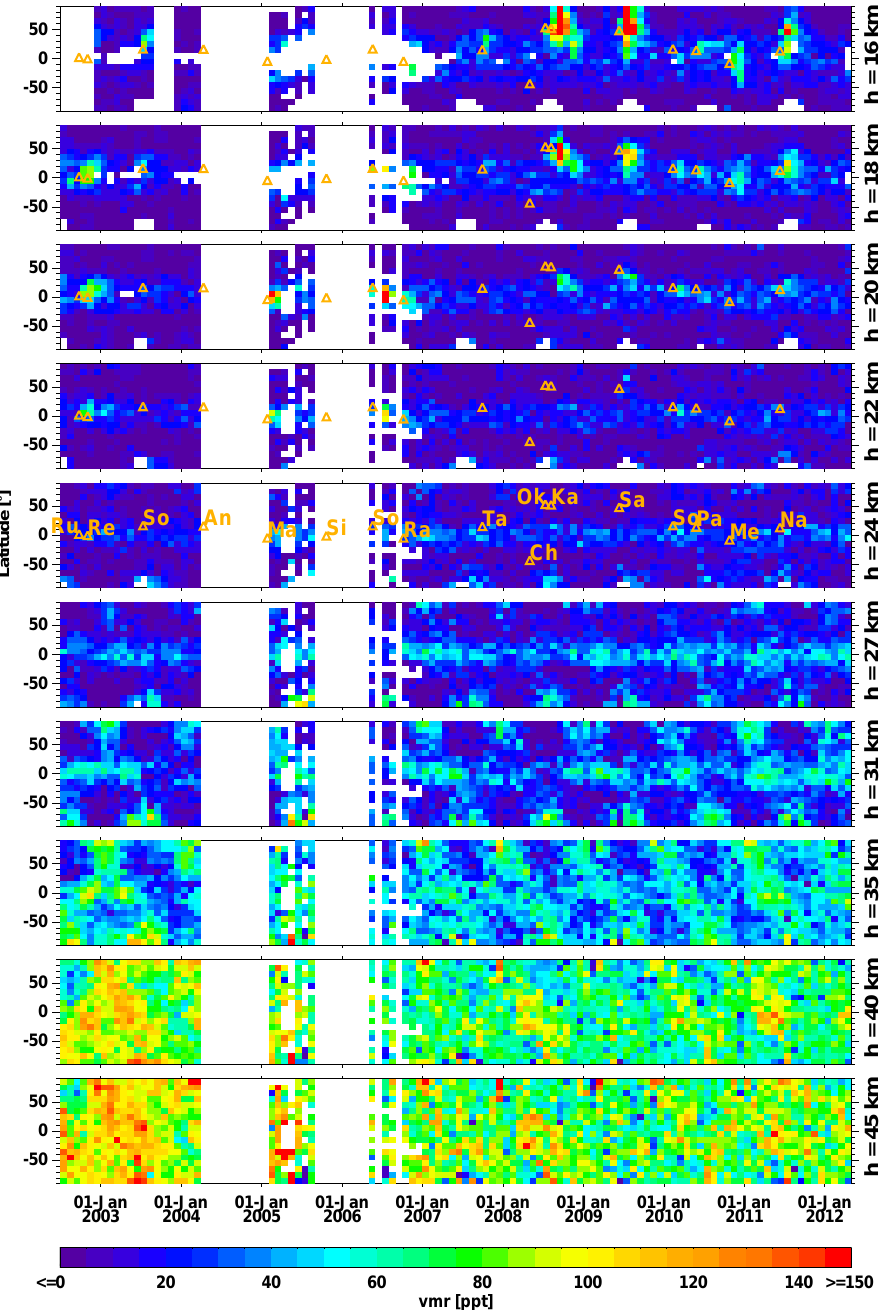
Fig. 6. Global time series of colour-coded SO 2 monthly mean distributions at various altitudes. The colour scale is restricted to 0–150pptv: negative values and those larger than 150pptv are given the colour corresponding to 0 and 150pptv, respectively. Major volcanic eruptions are indicated by the latitude of their location (Table